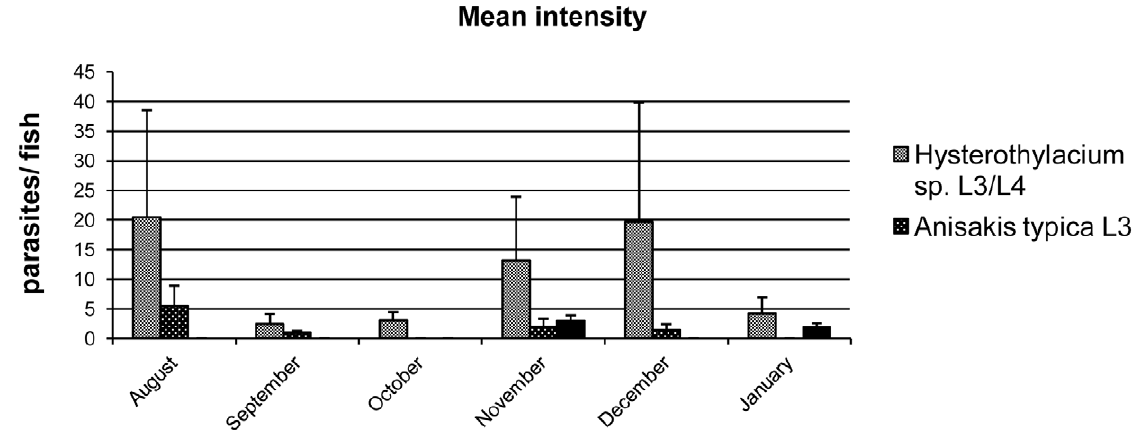
Figure 11. Ecological data of Anisakistypica and Hysterothylacium sp.: mean intensity (no. of parasites/parasitized fish); the bars represent the standard deviation.